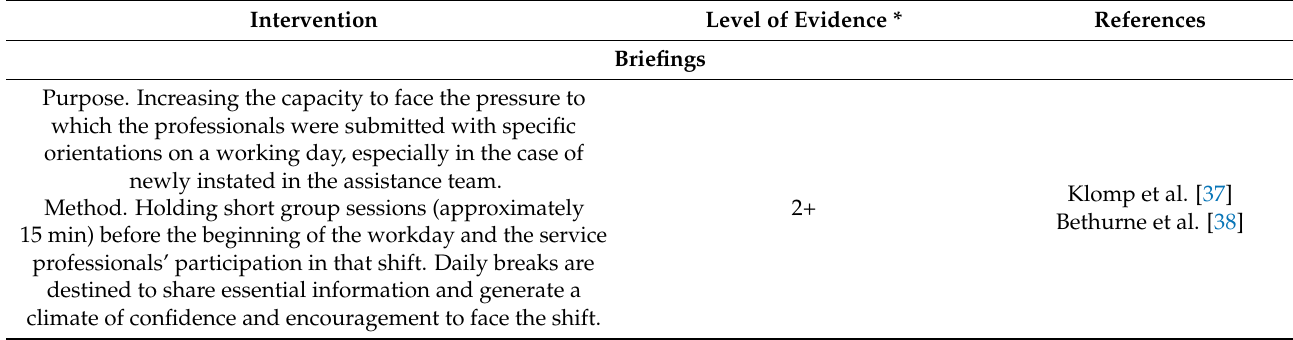
Table 4. Interventions to provide professionals with resources to deal with the emotional overload caused by caring for patients with COVID-19.